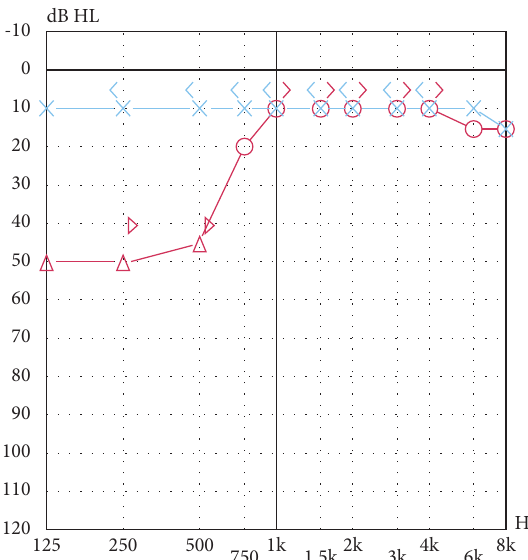
Figure 2: The audiogram showing low to medium frequencies sensorineural hearing loss on the second sister’s right